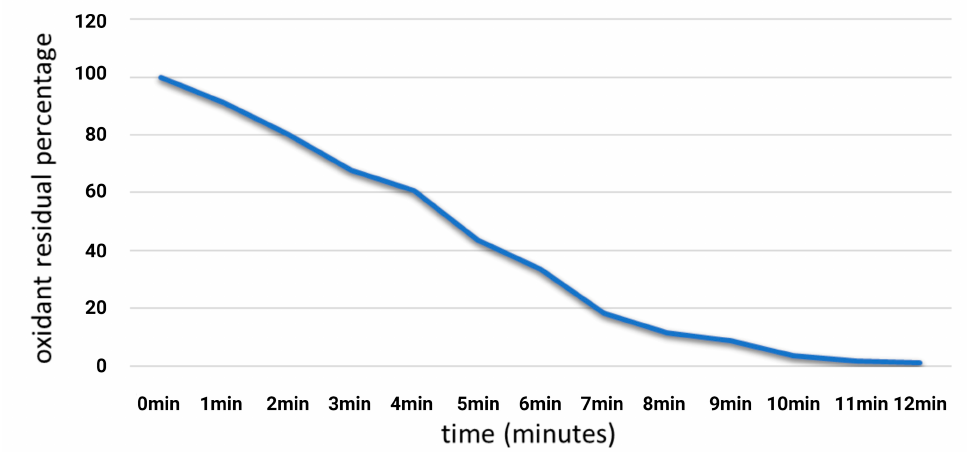
Figure 2. Percentage of Ozosan’s ozone release over time. According to the UNI EN ISO 3960:2017 standards, the total amount of peroxide in the gel was evaluated at 1322.4 meqO2/Kg (100%). The time-temperature-dependent release expressed in % indicates that after 10 min, about 97% of the initial peroxide had been released. Of note, at the same 2 min exposure time employed in our study, less than 20% of the peroxide had been released.